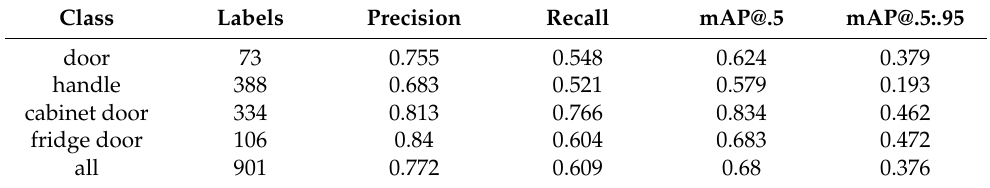
Table 7. Results of object detection with YOLOv7 on the DoorDetect validation